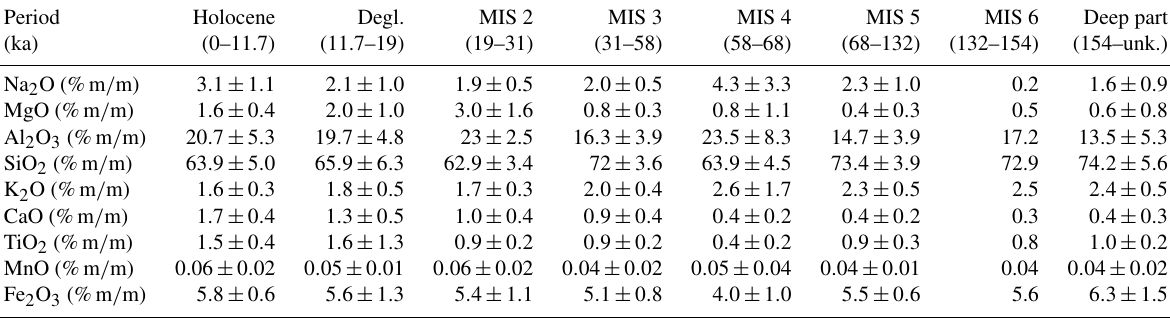
Table 2. Average major element composition of TALDICE dust. Data are expressed as percent mass fractions of oxides. For each climatic period mean values are reported with standard deviations.